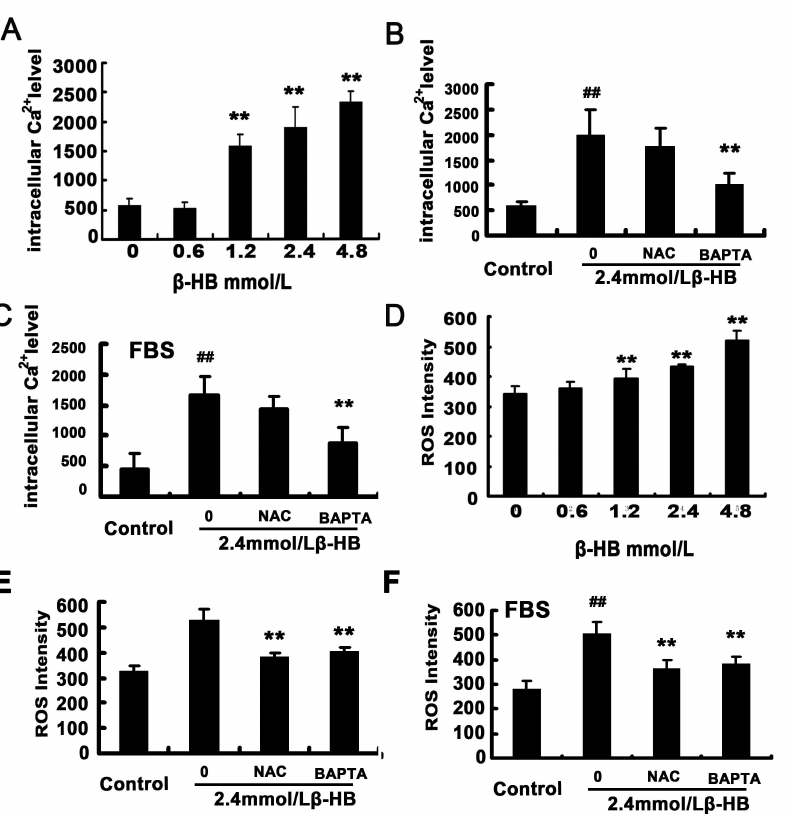
Figure 2. Effect of b -HB on intracellular ROS level and intracellular calcium level in BSMCs. Intracellular ROS level was measured with DCFH-DA by confocal microscopy. Intracellular calcium level was measured with Fura-3/AM by confocal microscopy. A) and D) Cells were incubated 12 h with b -HB (0, 0.6, 1.2, 2.4 or 4.8 mM) in serum-free medium. B) and E) Cells were incubated 12 h with b -HB (0, 2.4 mM) in serum-free medium with or without pretreatment with NAC (1 mM) or BAPTA/AM (15 m M). C) and F) Cells were incubated 12 h with b -HB (0, 2.4 mM) in medium with 10% FBS with or without pretreatment with NAC (1 mM) or BAPTA/AM (15 m M). The mean of three independent experiments is shown. *p , 0.05, **p , 0.01 versus control